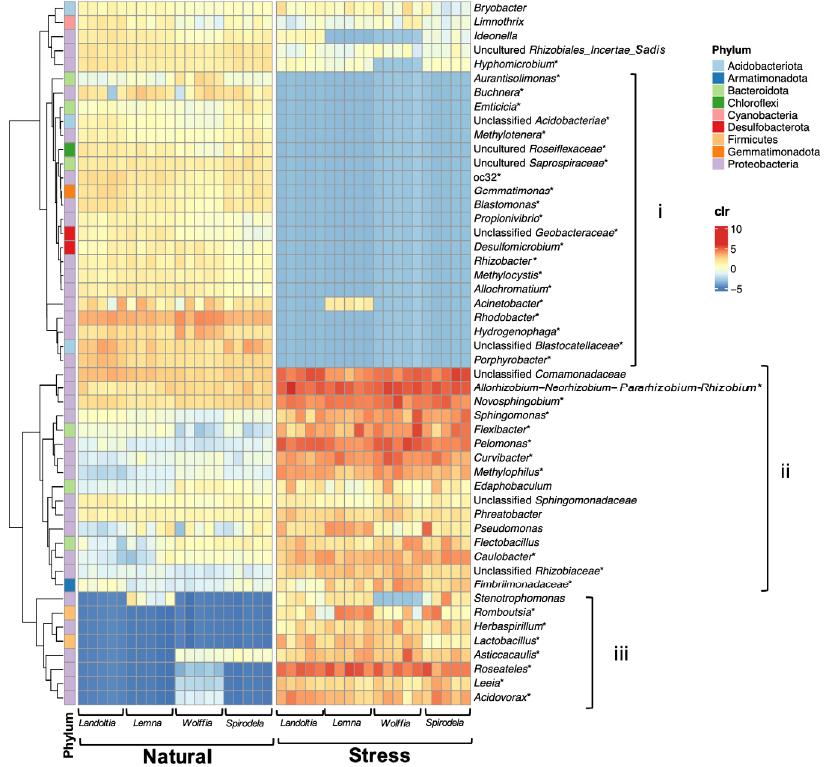
Figure 5. Top 50 abundant core genera of natural and stressed duckweeds (nutrient deficiency). The alteration of core microbiomes was categorized into: ( i ) high abundance in natural duckweeds but diminished under stress; ( ii ) high abundance in natural duckweeds and enriched under stress; and ( iii ) low abundance in natural duckweeds but highly enriched under stress. Asterisks (*) indicate significant difference based on ALDEx2, p -value <